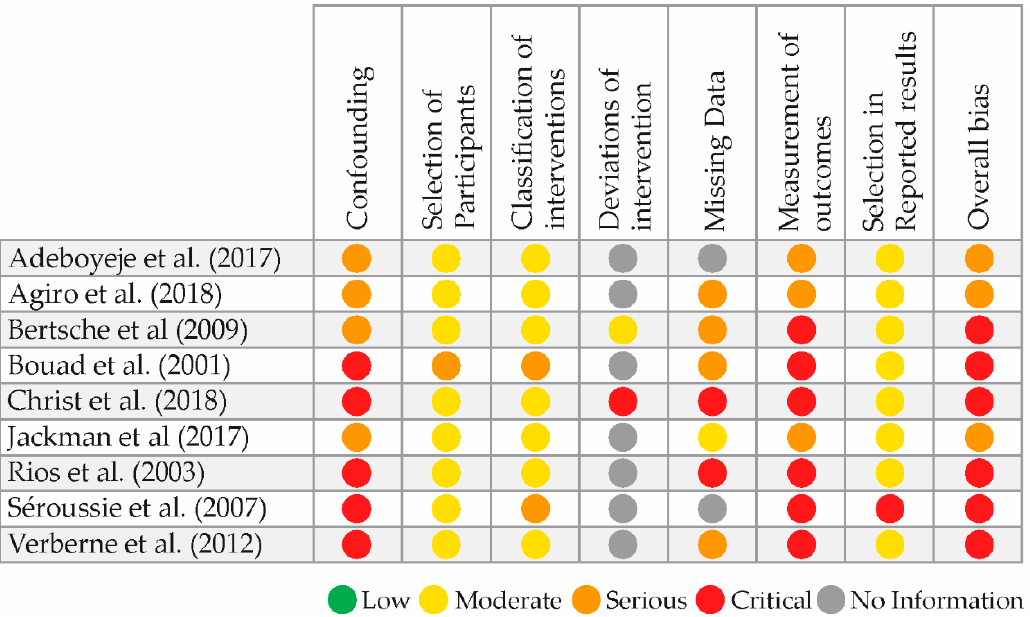
Figure 2. Risk of bias assessment.